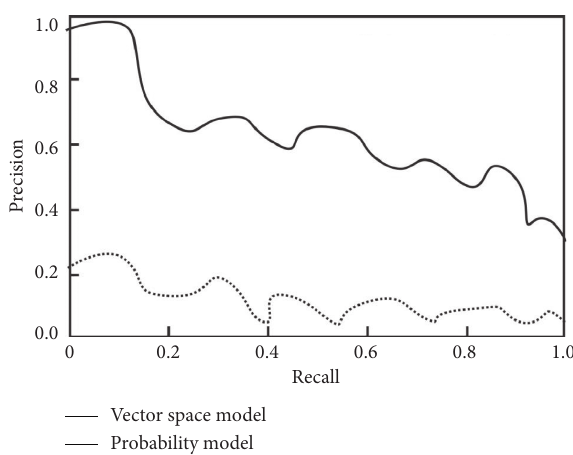
Figure 3: Comparison between the two